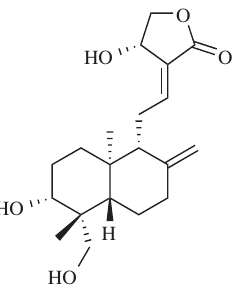
Figure 1: Molecular structure of